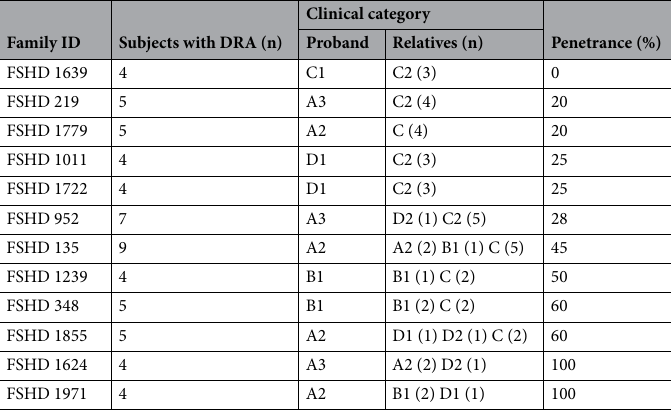
Table 4. Penetrance of bDRA in families with 4 or more carriers.